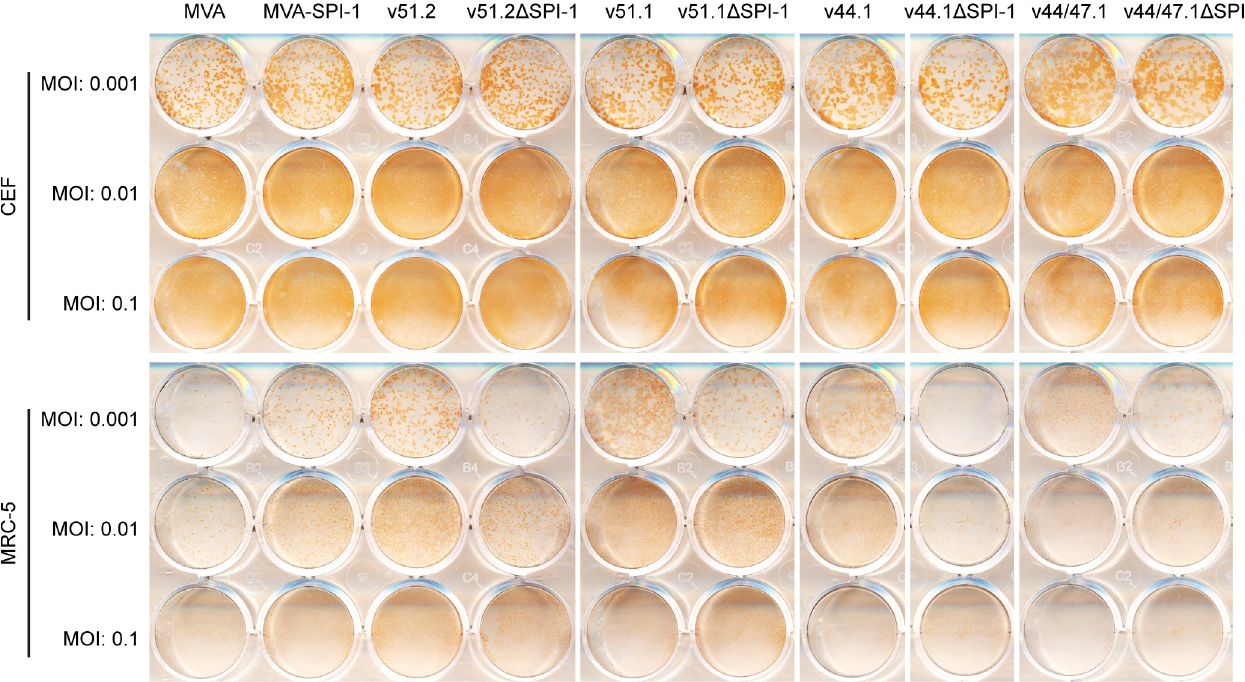
Fig 3. Effect of SPI-1 deletions on spread of additional HRE MVAs. CEF and MRC-5 cells in 12-well plates were infected with the indicated viruses at MOI of 0.001, 0.01, 0.1 and overlaid with methylcellulose. After 48 h, the overlay was removed and cells were stained with antibody to VACV.